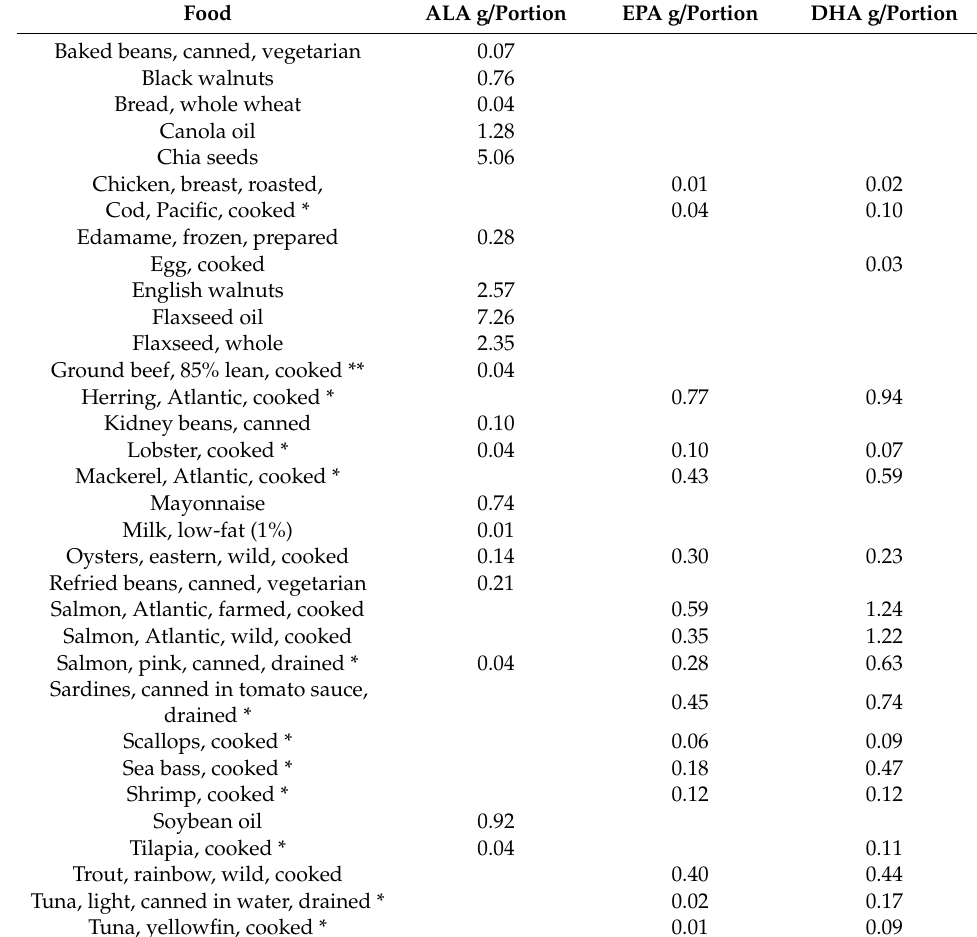
Table 2. Amount of α -linolenic acid (ALA), eicosapentaenoic acid (EPA), and docosahexaenoic acid (DHA). Food ALA g / Portion EPA g / Portion DHA g / Portion Baked beans, canned,